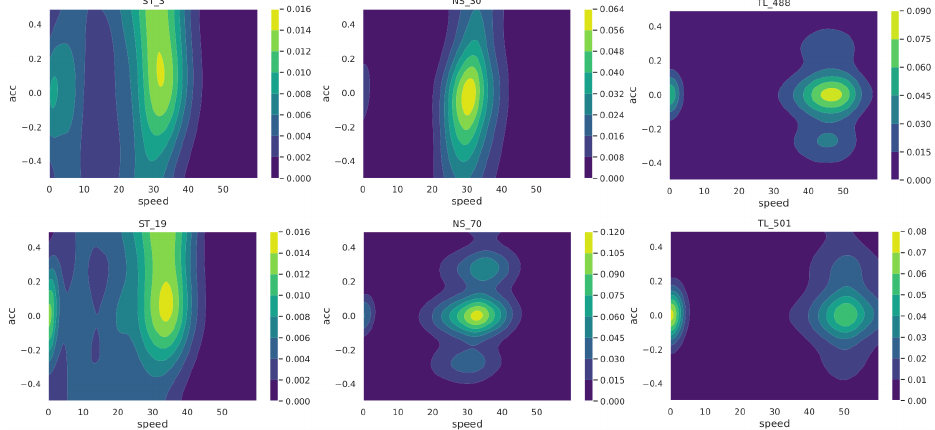
Figure 2. Speed–acceleration density contour plot for a given heading direction at two STs ( left ), NSs ( middle ) and TLs ( right ).